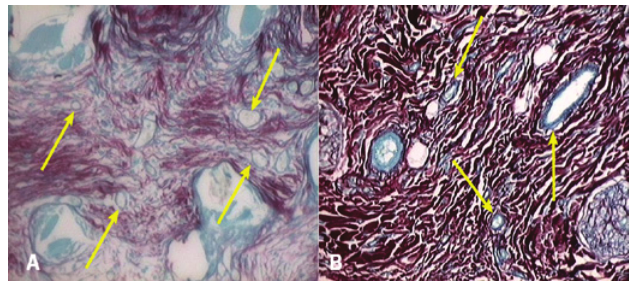
FIGURE 7 – Photomicrographs on 28 days subgroups. A . Polyurethane foam. B . Silicone foam (200x). Note: Arrows in A indicate vessels and ten vessels in collagen area of 6333.01 square micra and in B , arrows indicate the vessels and three vessels in the area of collagen of 90.20 square